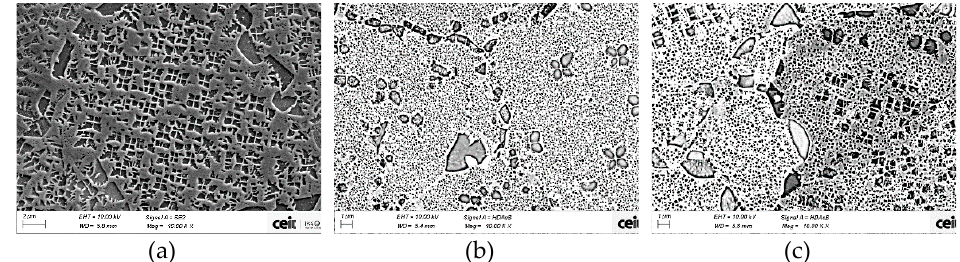
Figure 9. Hardness values in the inner and external part of the can.